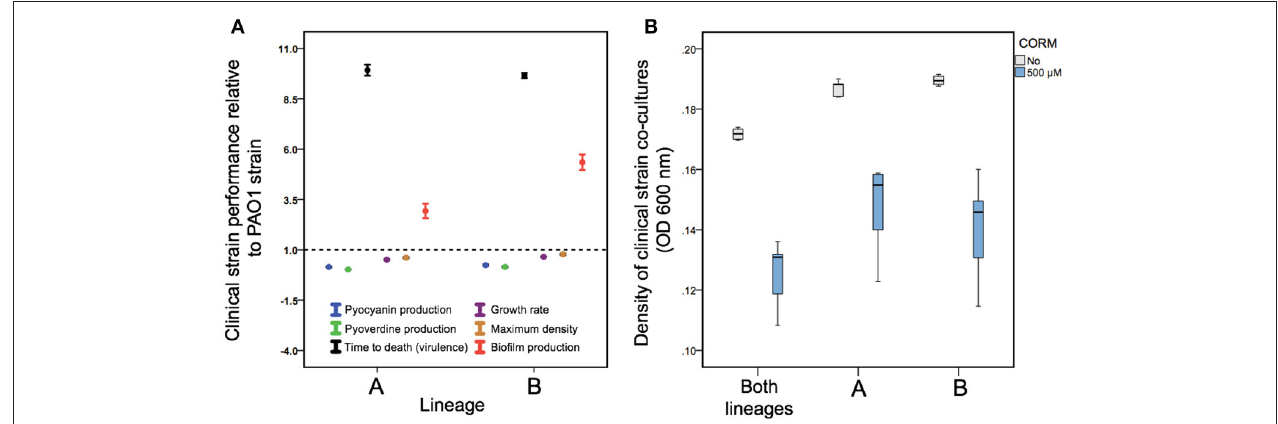
FIGURE 4 | Differences in P. aeruginosa growth and virulence trait variation between PAO1 and clinical CF isolates (A) and EBOR-CORM-1 effects on clinical CF isolate lineage mixes (B) . In (A) , different colors denote for pyocyanin (blue) and pyoverdine (green) production, time to death (black), growth rate (purple), maximum density (yellow) and biofilm production for clinical isolates belonging to lineages (A,B) . The dashed line shows the mean performance of PAO1 strain. (B) shows EBOR-CORM-1 effect on clinical CF isolate mixes after 24h of CORM application. In (A) , bars denote for ± 1s.e.m., and in (B) , extreme values around lower and upper quartile (black lines show the